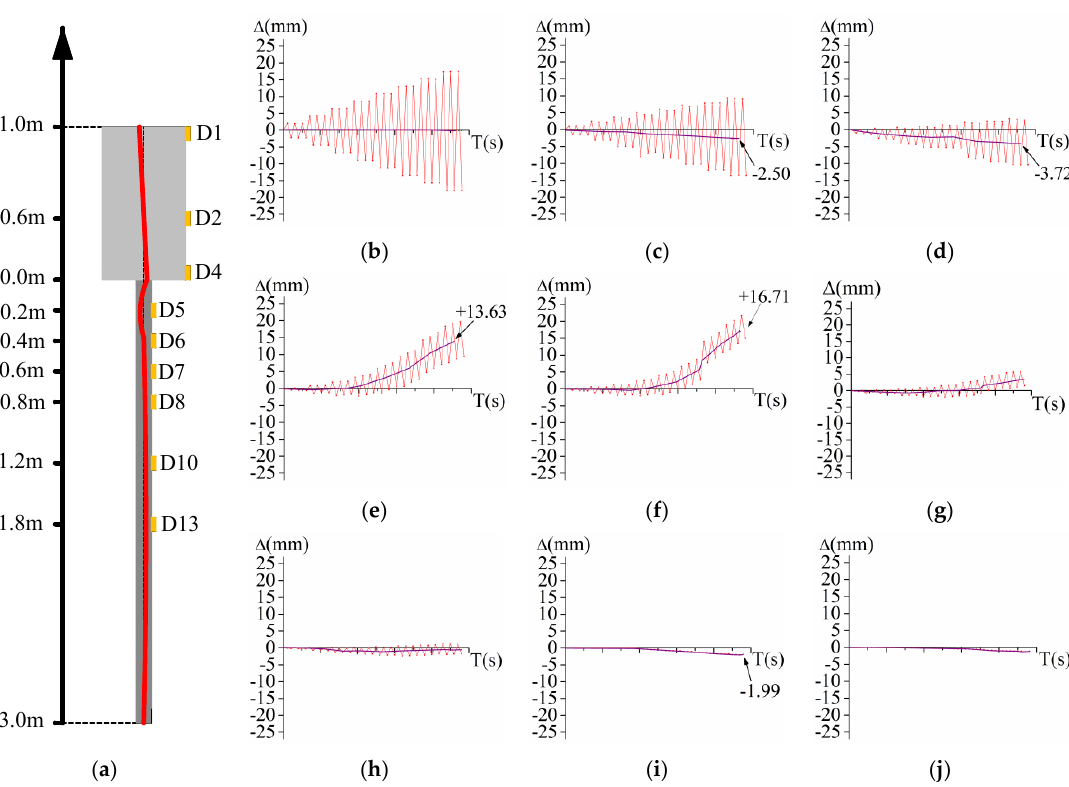
Figure 18. Time-history curves considering accumulative deformation. ( a ) The locations of nine measurement points and the distribution (red line) of the specimen considering accumulative deformation. ( b ) D1. ( c ) D2. ( d ) D4. ( e ) D5. ( f ) D6. ( g ) D7. ( h ) D8. ( i ) D10. ( j ) D13.